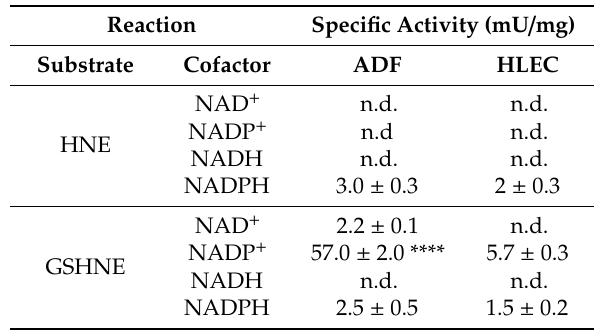
Table 1. Levels of pyridine cofactor-dependent oxido / reductase activities acting on 4- hydroxynonenal (HNE) and glutathionylhydroxynonanal (GSHNE) in cultured ADF cells and human lens epithelial cells